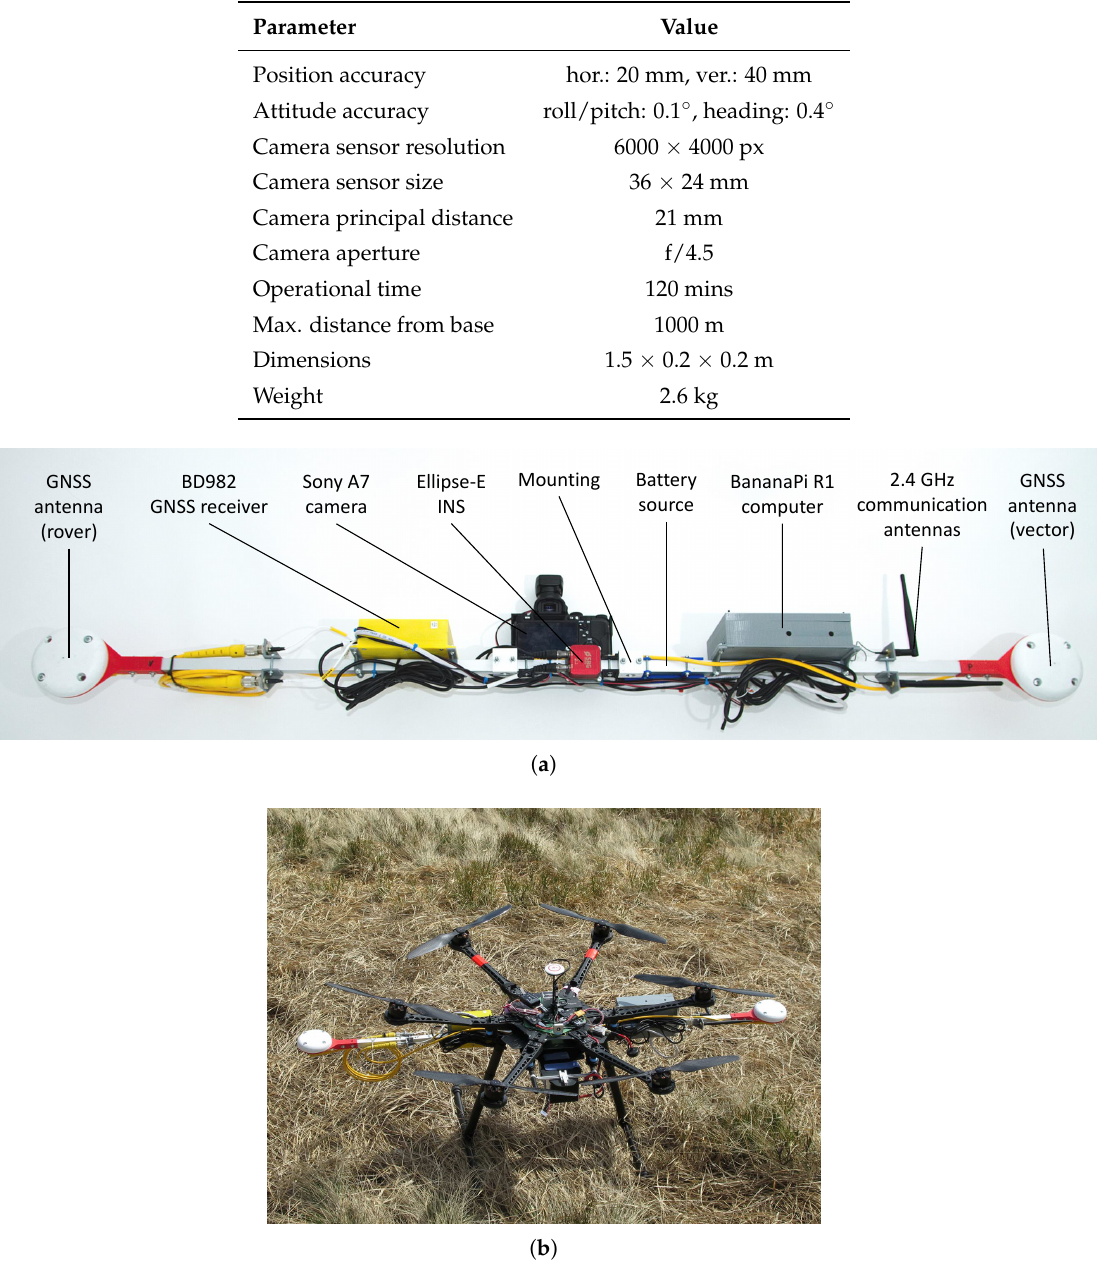
Table 1. The parameters of the custom-built multi-sensor system for UASs. The position and attitude accuracy according to the INS manufacturer’s specifications (the RTK mode, airborne applications).